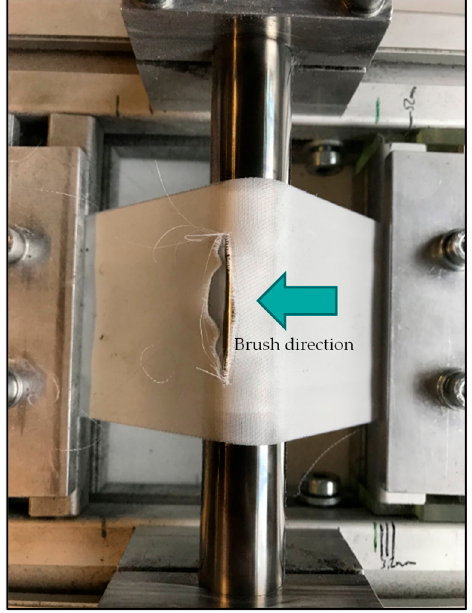
Figure 5. Point of rupture for the thin nylon cloth clamped over a circular edge geometry.